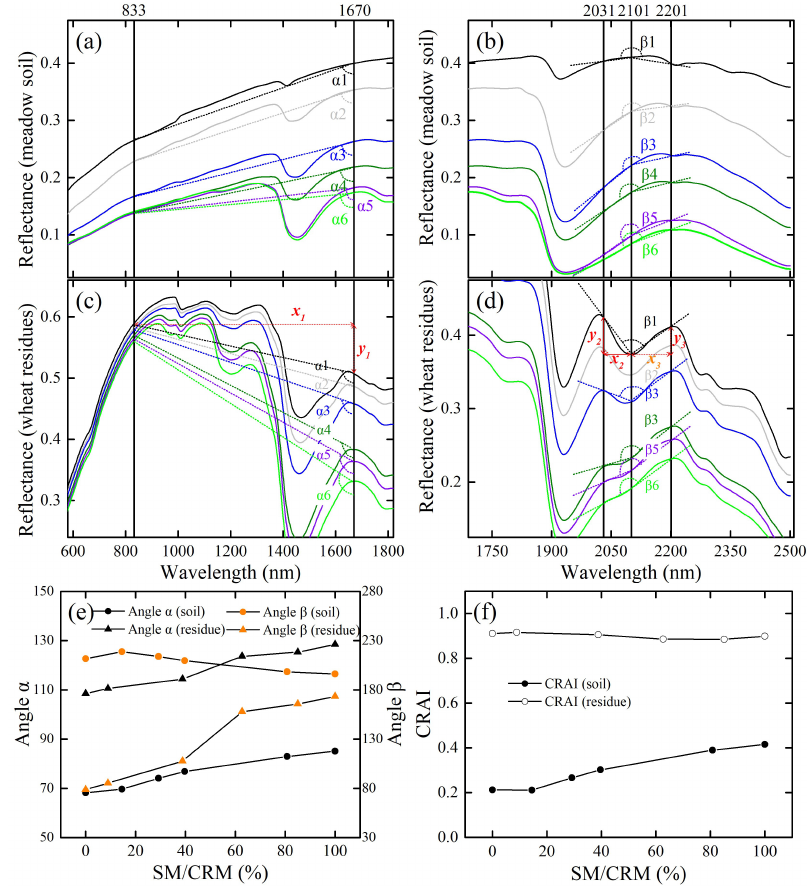
Figure 3. Angles α and β as a function of crop residue moisture and soil moisture content (same hyperspectral data as shown in Figures 1 and 2).